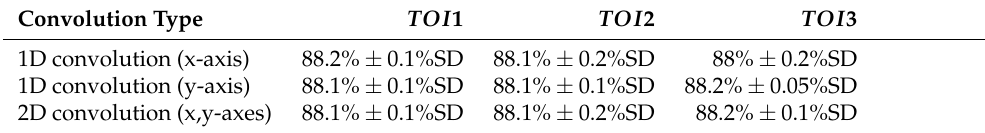
Table 3. The F 1-score for correct responses depending on the convolution type and the EEG segment. Convolution Type TOI